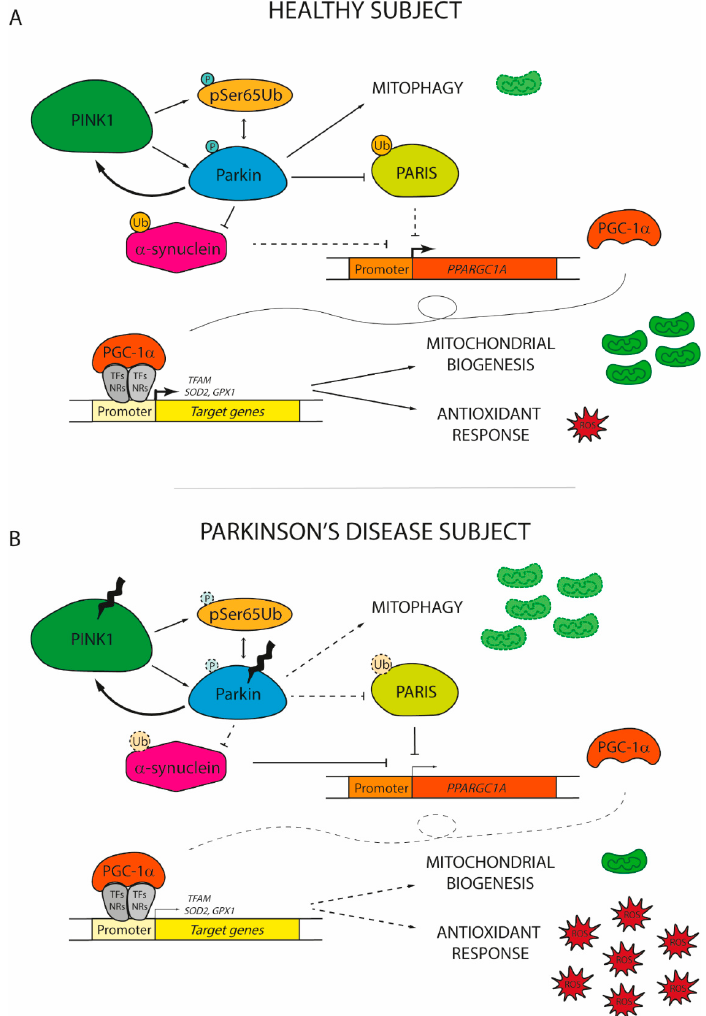
Figure 2. The role of peroxisome proliferator-activated receptor gamma coactivator 1 (PGC- 1 α ) in the onset of Parkinson’s disease. ( A ) In healthy subjects, damaged mitochondria are promptly replaced with new functional organelles. Mitochondrial depolarization induces PTEN-induced putative kinase 1 (PINK1) to phosphorylate serine 65 residue of ubiquitin (pSer65Ub) and of Parkin, which in turn interact together to increase the PINK1 phosphorylation rate of Parkin. The activation of the PINK1/Parkin pathway promotes the degradation of dysfunctional mitochondria via mitophagy and concomitantly induces the expression of PGC-1 α by the ubiquitination of PARIS and α -synuclein. By coactivating nuclear receptors (NRs) or transcription factors (TFs), PGC-1 α promotes the expression of genes involved in mitochondrial biogenesis (mitochondrial transcription factor A, TFAM ) and antioxidant response (superoxide dismutase 2, SOD2 ; glutathione peroxidase 1, GPX1 ). ( B ) In Parkinson’s disease individuals, PINK1 and Parkin usually display loss- of-function mutations. Therefore, the PINK1/Parkin axis cannot prevent the accumulation of dysfunctional mitochondria due to its inability to sustain mitophagy. At the same time, altered Parkin fails to promote the degradation of both PARIS and α -synuclein, which start to accumulate in the nucleus inhibiting PGC-1 α transcription. The low levels of PGC-1 α observed in PD patients are not sufficient to induce the expression of genes involved in the renewal of mitochondria and in the antioxidant response. Thereby, reactive oxygen species (ROS) start to accumulate, finally leading to the damage and the death of dopaminergic neurons. Dashed lines and soft colours represent inhibited